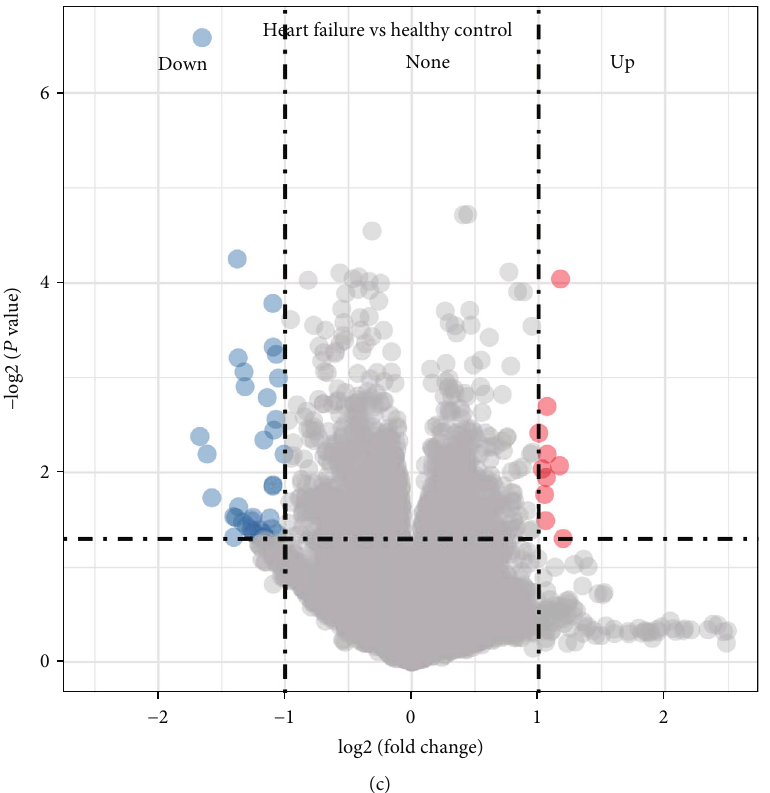
Figure 2: Di ff erentially expressed gene analysis on the GSE21125 dataset: (a) volcano plot of di ff erential analysis of acute heart failure patients vs. healthy individuals; (b) volcano plot of di ff erential analysis of chronic heart failure patients vs. healthy individuals; (c) volcano plot of di ff erential analysis of heart failure patients vs. healthy